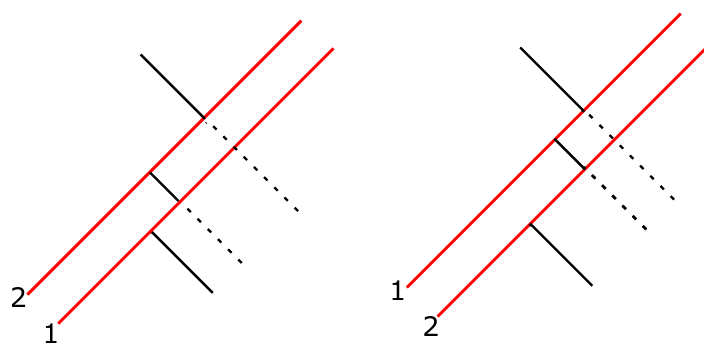
Figure 1. The probe geodesic is denoted by a black line and shock waves by red lines. Dashed lines mark time delay associated to each shock. In General Relativity propagation through a pair of closely situated shockwaves is commutative, namely the overall effect does not depend on the order of the shocks. This is no longer true in theories with higher derivative corrections. We argue that commutativity must hold in any UV complete